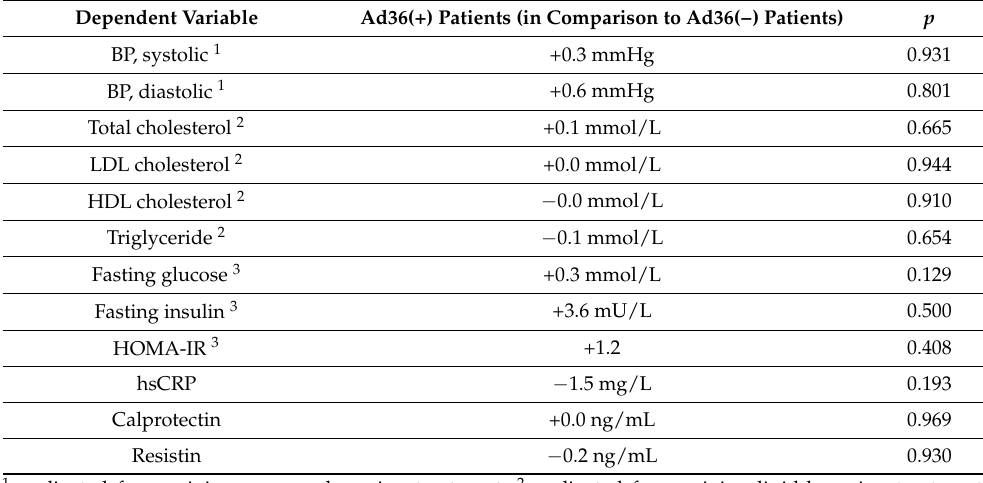
Table 3. Adv36-serostatus and cardiovascular risk factors adjusted through multiple regression analysis: age, gender, sexuality (MSM vs. other), ARV therapy (receiving TAF vs. not receiving TAF; receiving an INSTI vs. not receiving an INSTI), CD4 + percentage, treatment (where appropriate, see indexes), and waist-to-hip ratio. Dependent Variable Ad36(+) Patients (in Comparison to Ad36(−) Patients) BP, systolic 1